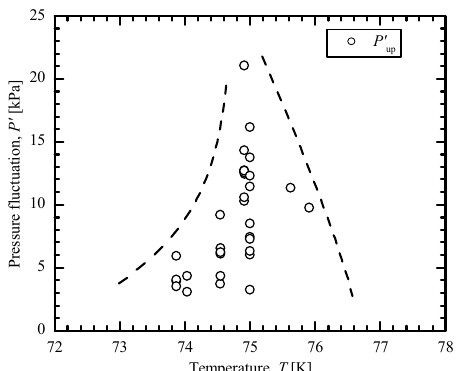
Fig.13 Distribution of the peak amplitude of the low frequency component of the pressure fluctuation upstream of the